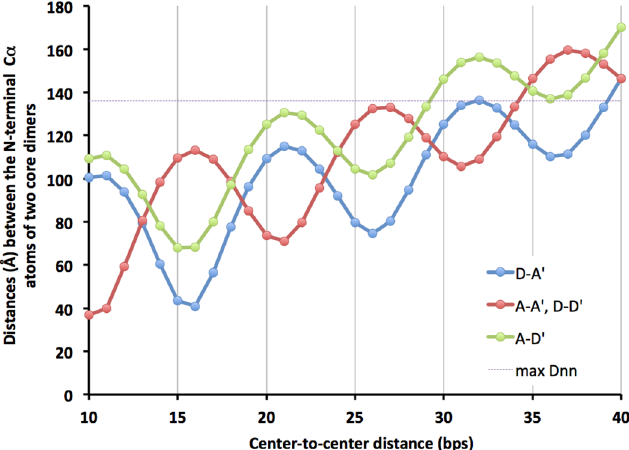
same as that between the monomers A-A ’ . The dotted line is at the distance of 136 Å , which is an expected upper limit of distances that can be spanned by an NDD with two 13-mer peptides. See Methods for the procedure used to calculate these distances.